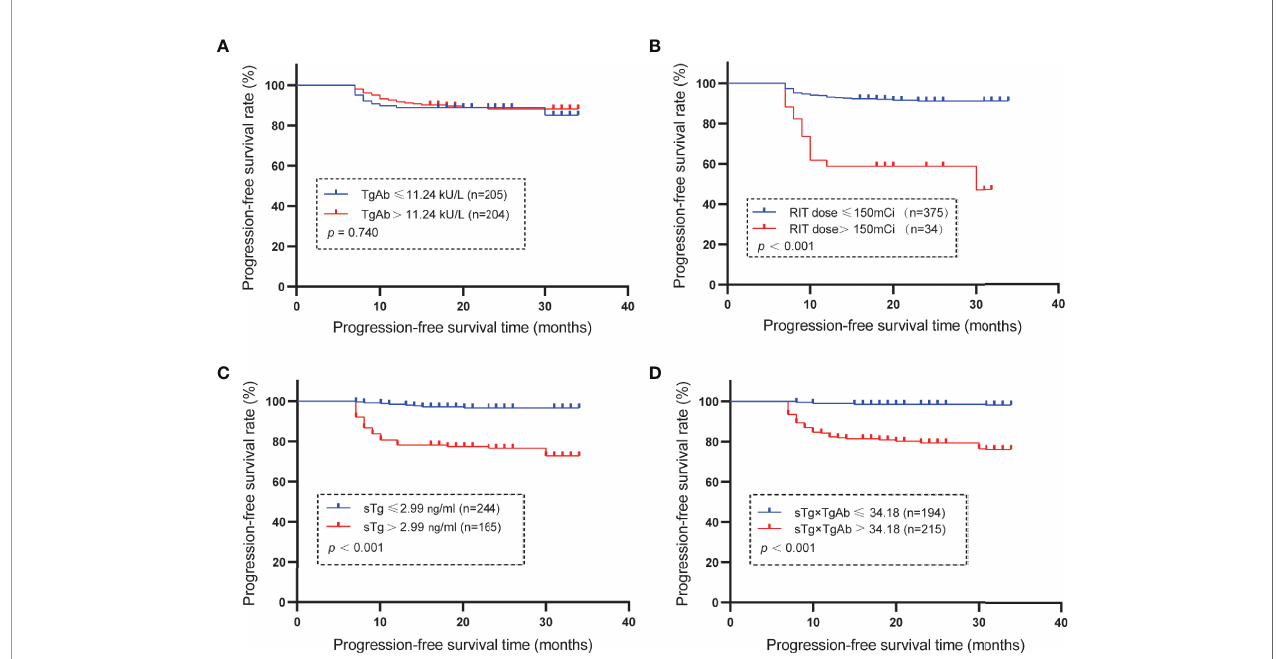
FIGURE 3 | Mean PFS. (A) Mean PFS in the group of patients with TgAb ≤ 11.24 kU/L or >11.24 kU/L (the median of TgAb). The PFS was 30.96 months with TgAb ≤ 11.24 kU/L and 31.34 months for TgAb >11.24 kU/L ( p = 0.740). (B) Mean PFS of the subset with RAIT dose ≤ 150 or > 150 mCi (the median of RAIT dose). The PFS was 31.91 months in patients with RAIT dose ≤ 150 mCi and 22.21 months with RAIT dose >150 mCi ( p < 0.001). (C) Mean PFS in the subgroup of patients with sTg ≤ 2.99 or >2.99 ng/ml. The PFS was 33.26 months in patients with sTg ≤ 2.99 ng/ml and 28.06 months with sTg >2.99 ng/ml ( p < 0.001). (D) Mean PFS in the group of patients with sTg×TgAb ≤ 34.18 or >34.18. The PFS was 33.64 months with sTg×TgAb ≤ 34.18 and 28.92 months for sTg×TgAb >34.18 ( p < 0.001).